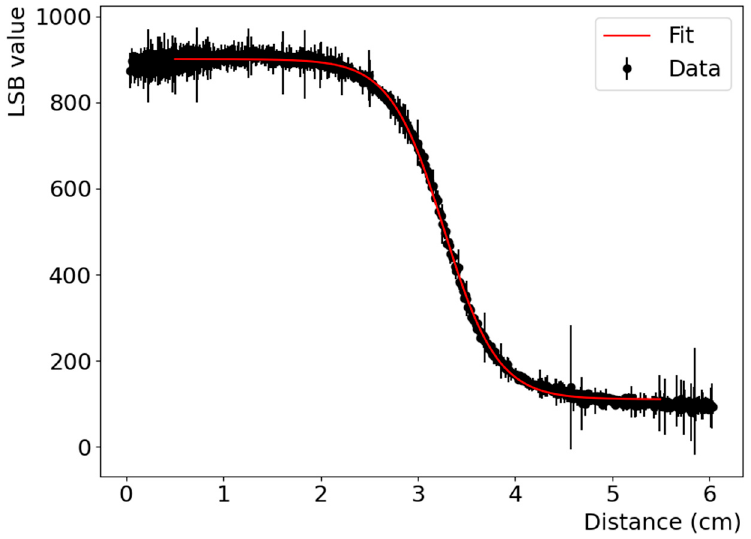
Figure 6. Edge response profile for 40 kV X-rays using a 2.5 cm thick lead block. The red line represents a logistic function fit to the data.